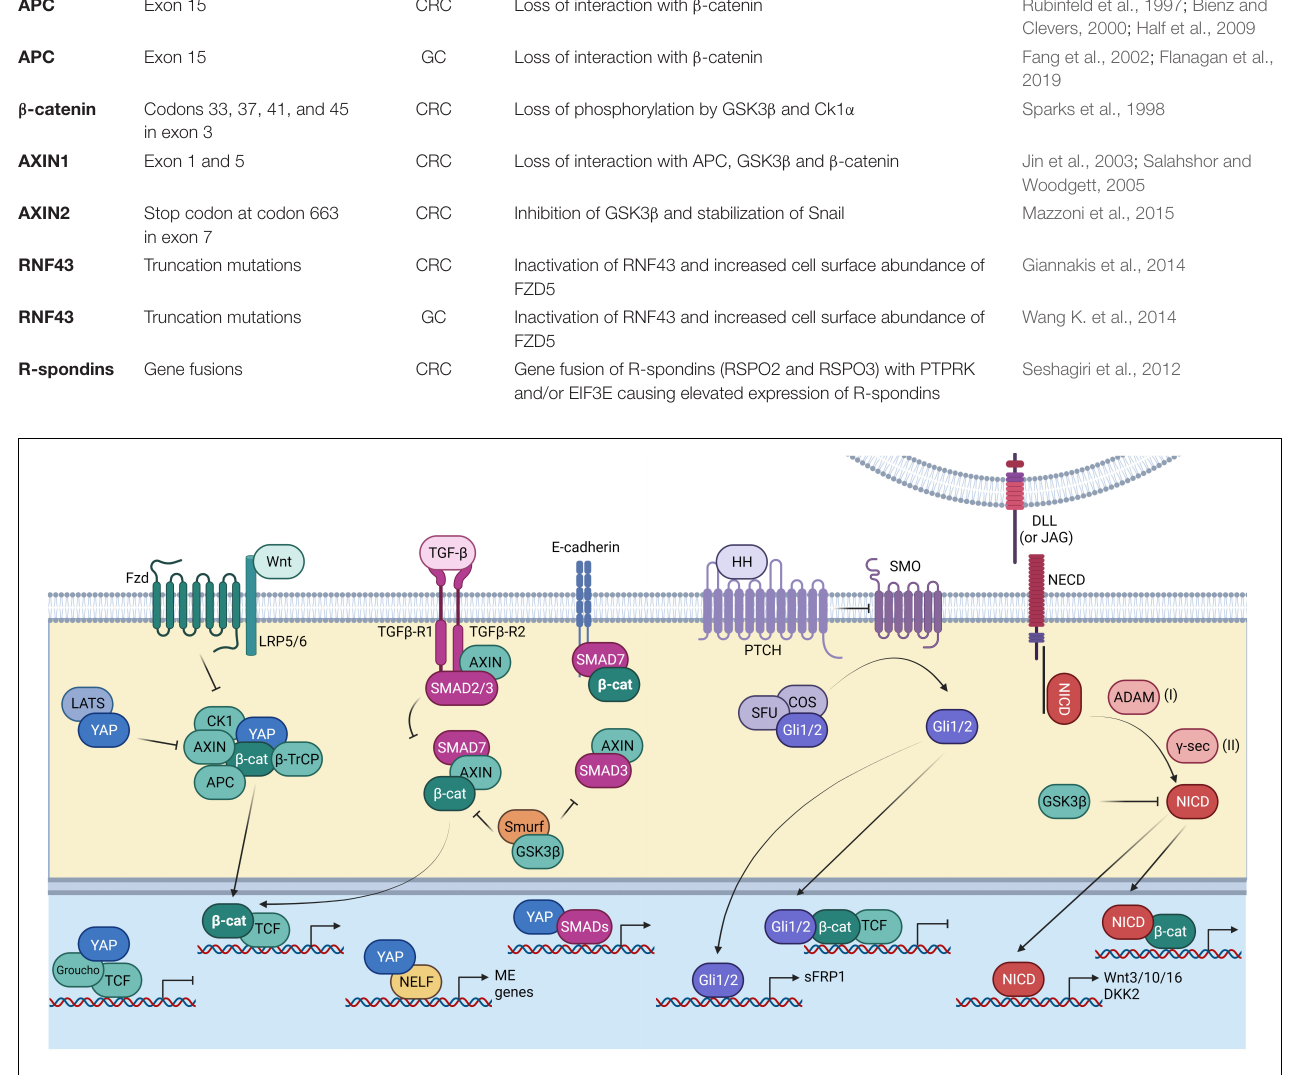
FIGURE 3 | Interplay of the Wnt pathway with other pathways. Summary of the interaction of the Wnt pathway components (depicted in green) with other signaling pathways, including the Hippo pathway (depicted in blue), TGF- β pathway (depicted in magenta), Hedgehog pathway (depicted in purple), and Notch pathway (depicted in red). The Hippo pathway helps in the stabilization of β -catenin by inhibiting YAP’s interaction with the Wnt destruction complex, thereby preventing the recruitment of β TrCP. TGF- β signaling has synergistic effects with Wnt signaling. SMAD7 can help in preventing the GSK-3 β mediated β -catenin degradation. The Hedgehog effector Gli1/2 can inhibit Wnt target gene expression by directly binding to the β -catenin/TCF complex. It can also drive the expression of the Wnt inhibitor sFRP1. The Notch signaling transcription factor, NICD, interacts with β -catenin. NICD can promote Wnt signaling by promoting the expression of the Wnt ligands. However, the Wnt inhibitor DKK2 is also a target of NICD. NICD itself is a substrate of GSK- β